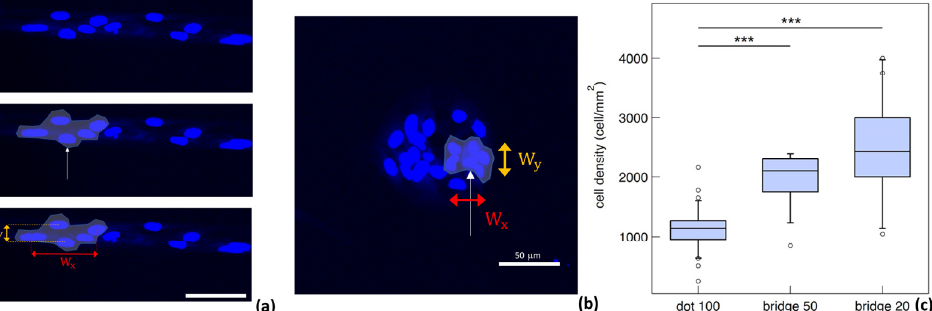
Figure 6. ( a , b ) Fluorescence images of nuclei of astrocytes confined on patterned nanostructured zirconia with bridges 20 μ m large and dots 100 μ m in diameter. In ( a ), we provide a schematic representation of the astrocyte cluster eccentricity analysis procedure: identification of a nucleus and its first 4 nearest neighbours, and calculation of the horizontal and vertical width of the cluster. In ( b ), the same procedure was performed for astrocytes cultured on nanostructured zirconia microdot. ( c ) Boxplot of the median density of astrocytes in different regions of the pattern. The symbol * stands for